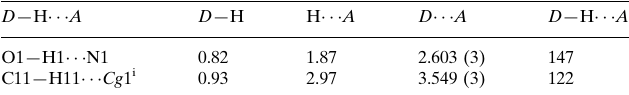
Hydrogen-bond geometry (A˚ , (cid:2)